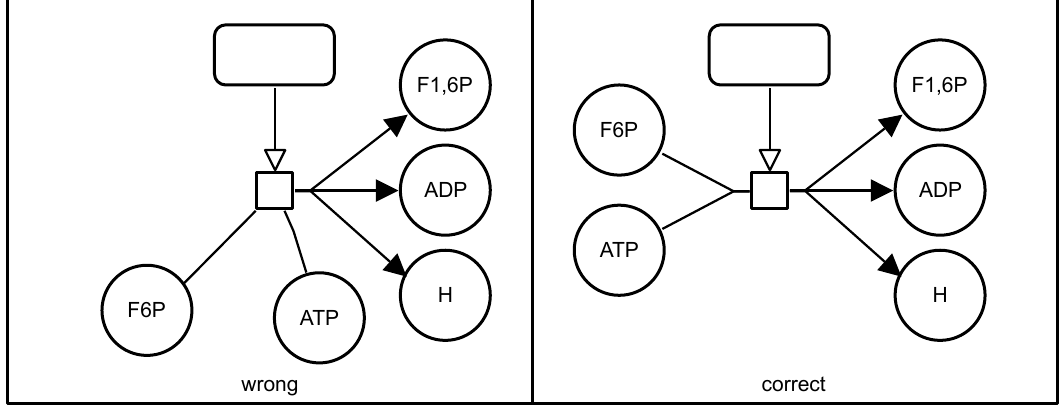
Figure 4.6: Arcs between a process and the consumption and production arcs must be at- tached to the centre of opposite sides, modulatory arcs must be attached to the other two